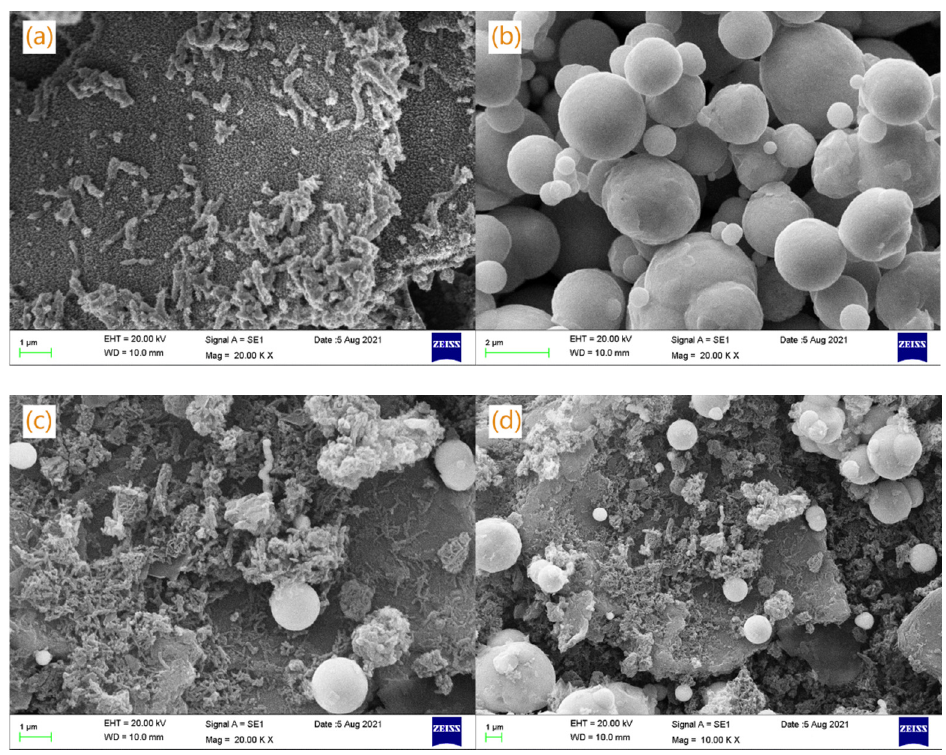
Figure 4. SEM images of ( a ) GO − PANI, ( b ) CIP, ( c ) and ( d ) CIP − GO − PANI (CIP:GO − PANI = 1:1).